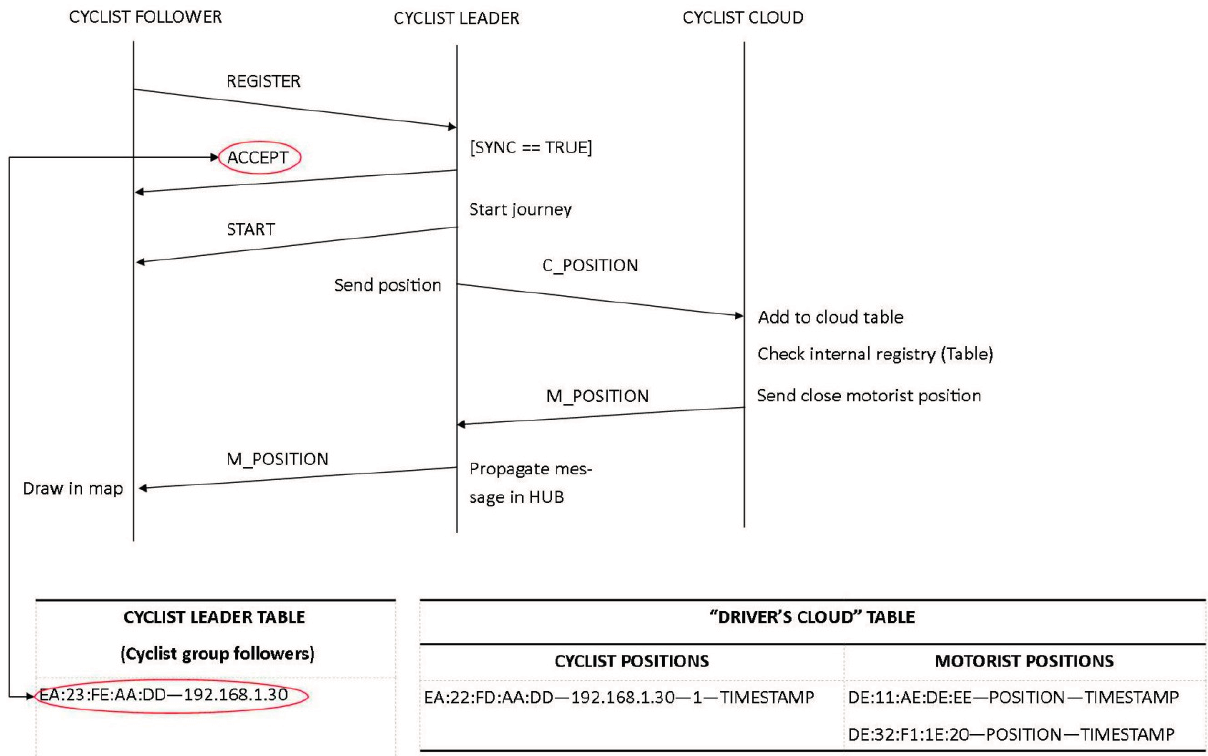
Figure 11. Communication protocol between cyclists and the Drivers